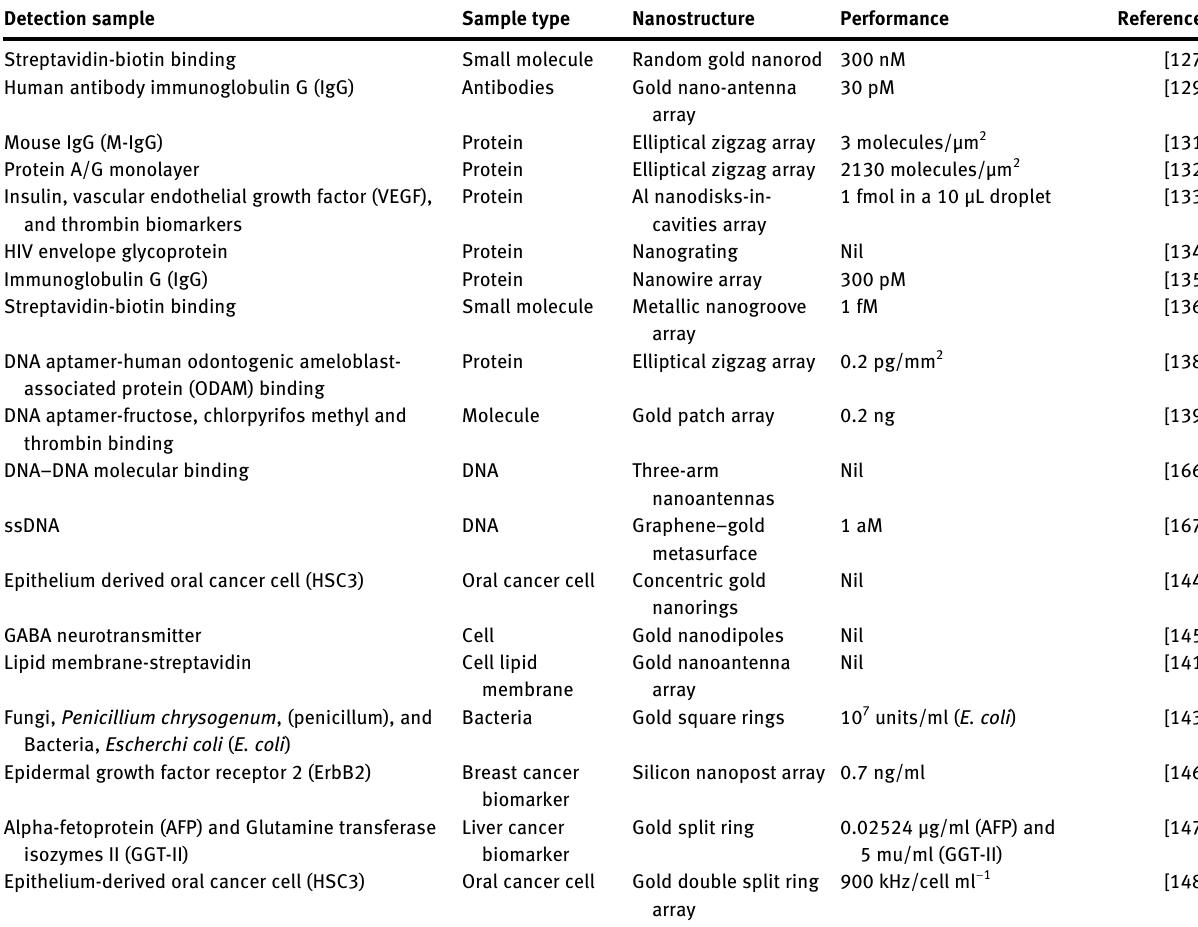
Table  : Summary of metasurface biosensors. Detection